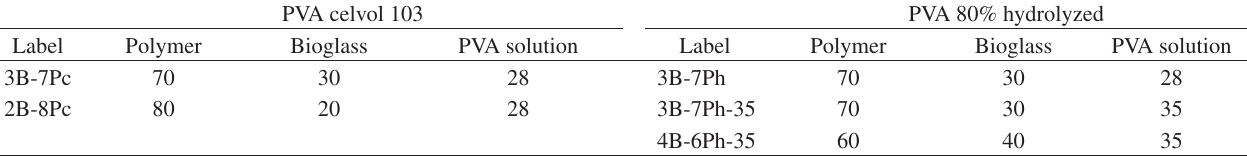
Table 1. Sample labels, composition (wt. (%)) and PVA solution concentration (wt. (%)) of the hybrids. PVA celvol